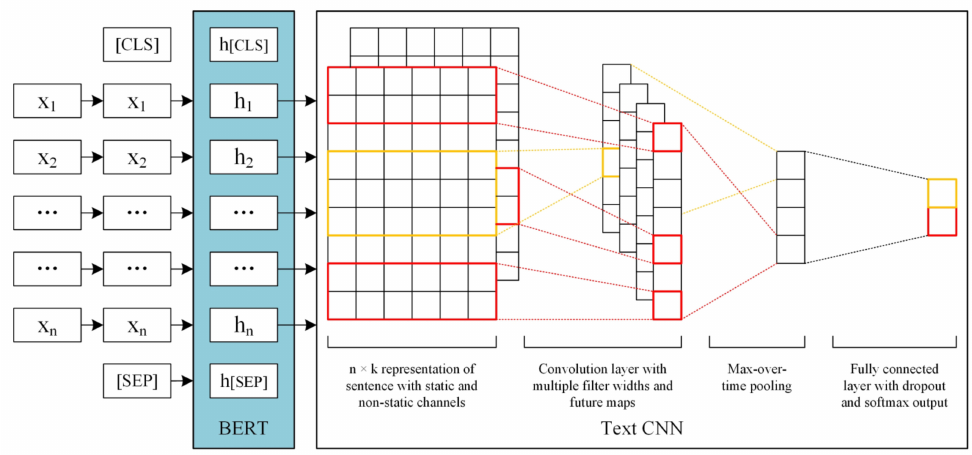
Figure 3. Semantic Identification Based on